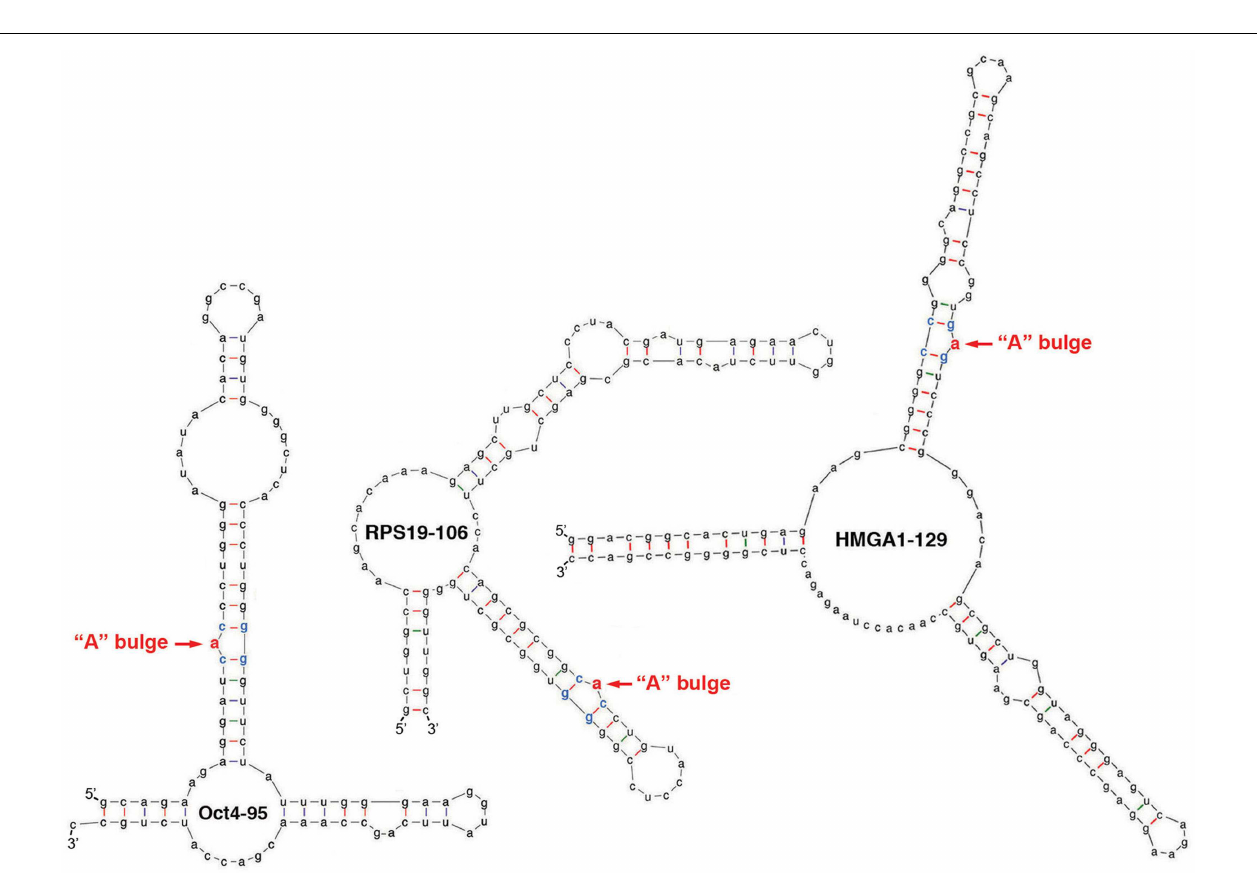
FIGURE 1 | Structural characteristics of LREs. Shown are computationally predicted secondary structures of LREs derived from ORFs of three Lin28 targets Oct4, RPS19, and HMGA1.The critical “A” bulges are highlighted in red.